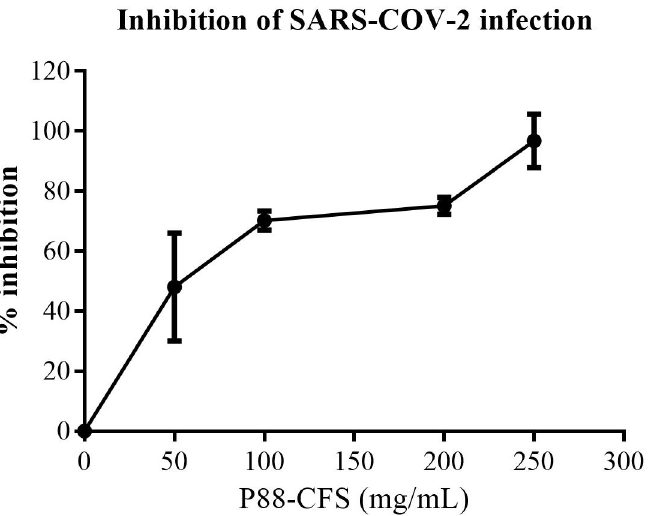
Figure 1. Inhibition of late-stage viral infection in HEK293. After 2 h p.i., DMSO or P88-CFS was added. Control samples were treated in the same manner with the same volume of DMSO. Data are represented as the means ± SD of 3 independent experiments.